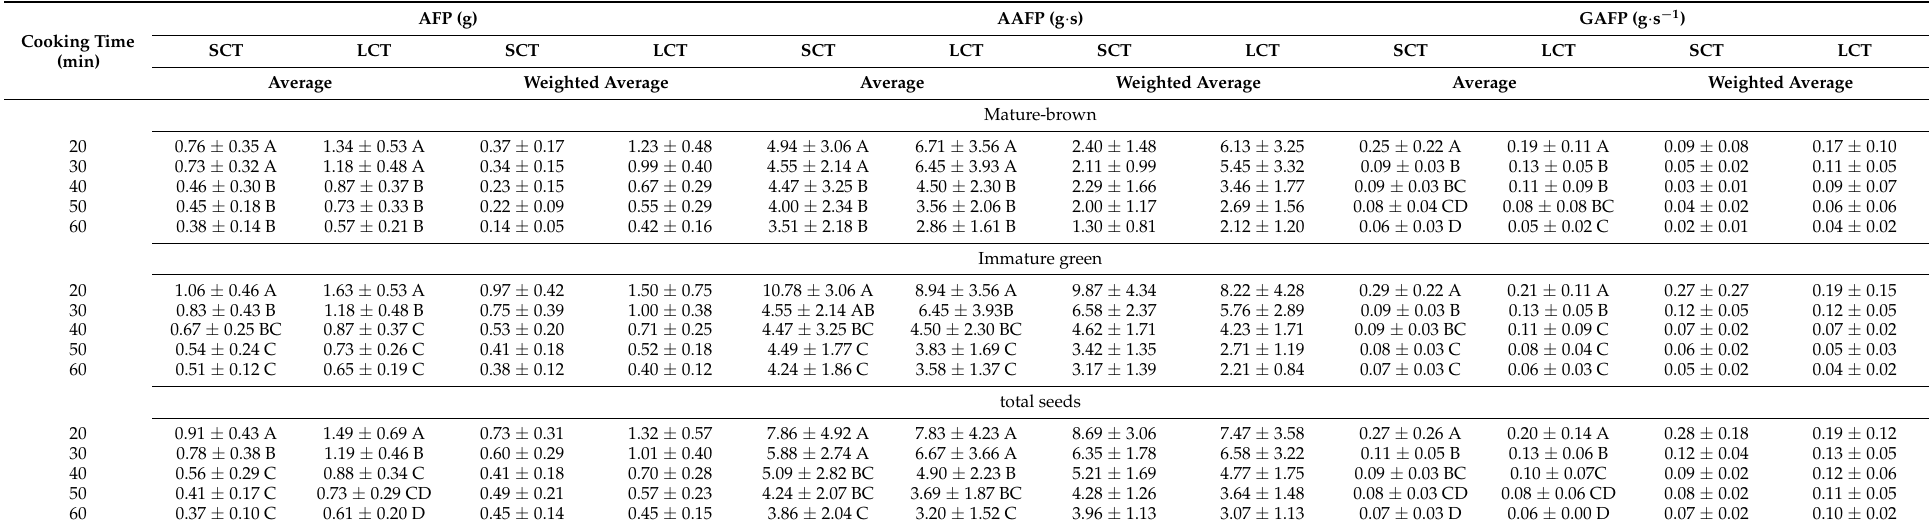
Table 3. Average and weighted APF (absolute positive force), AAPF (area to absolute positive force), and GAPF (gradient to absolute positive force) values of MB, IMG, and total lentil seed samples, either easy (SCT) or hard (LCT), during cooking at 100 ◦ C for 20–60